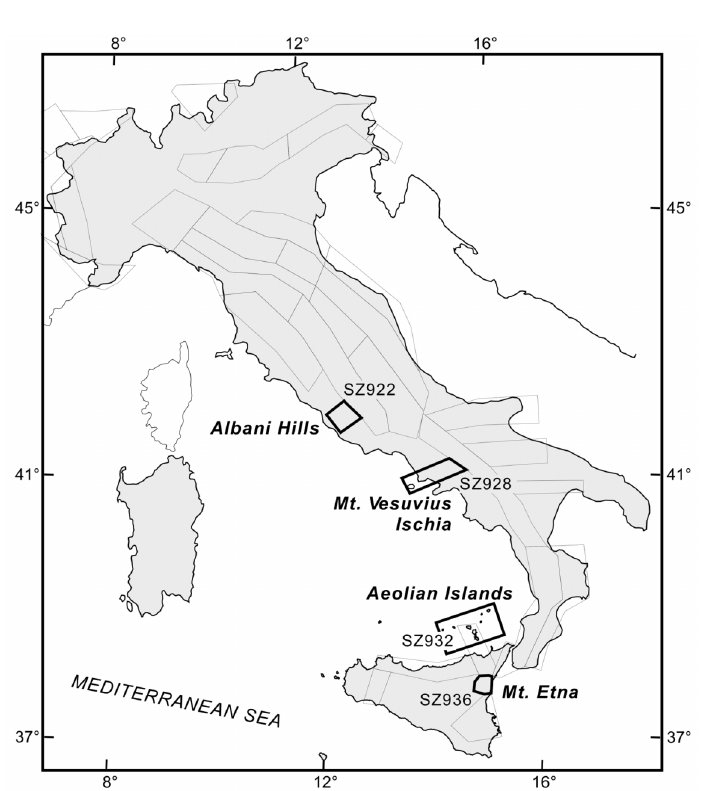
Fig. 1. Location of the studied volcanic areas (thick boxes) in the framework of the seismogenic zoning (thin polygons) used in the latest Italian seismic hazard map (Gruppo di Lavoro, 2004).